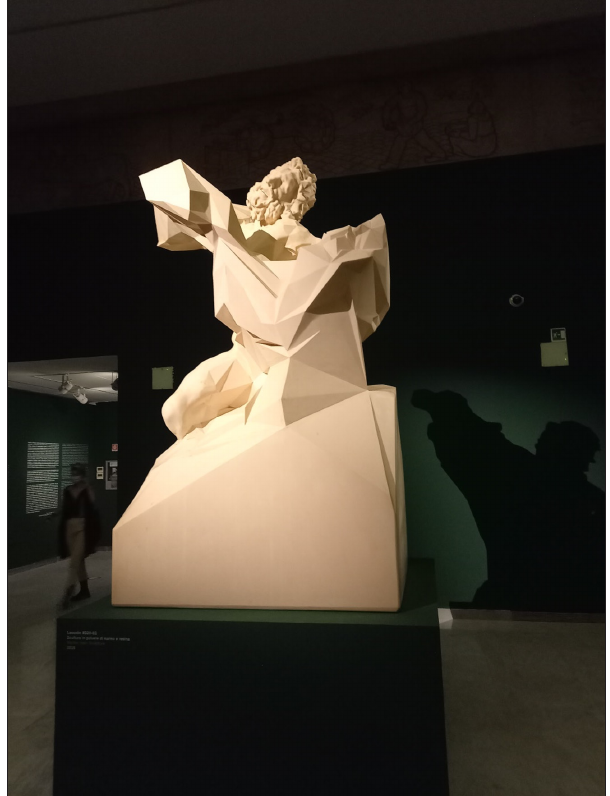
Figure 5: Davide Quayola. Laocoön #D20-Q1, 2016. Photo Susan Broadhurst, 29 th September,